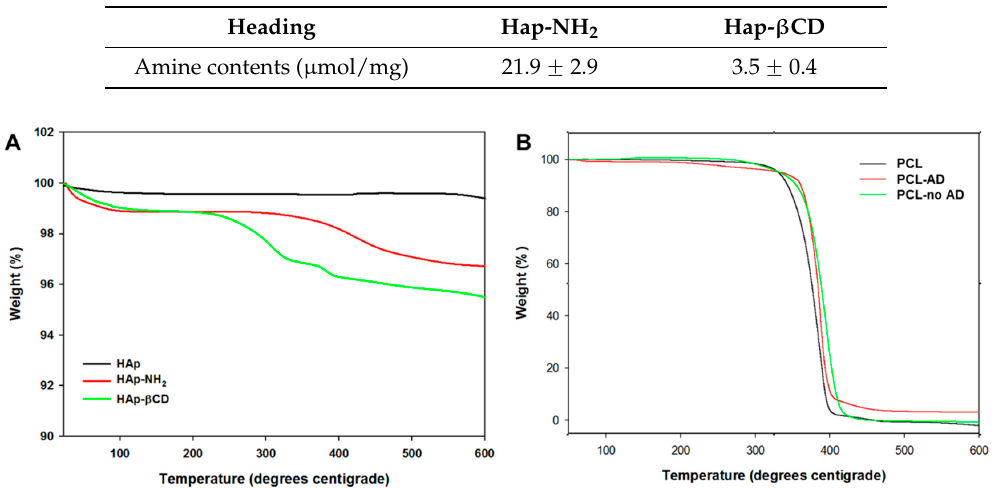
Figure 3. X-ray photoelectron spectroscopy (XPS) analysis of β -cyclodextrin ( β CD) grafted Hydroxyapatite (HAp), 3-aminopropyltriethoxysilane (APTES) grafted HAp, and pure HAp powders. Table 1. Amine contents of 3-aminopropyltriethoxysilane (APTES)-grafted hydroxyapatite (HAp) and β -cyclodextrin ( β CD)-grafted HAp.